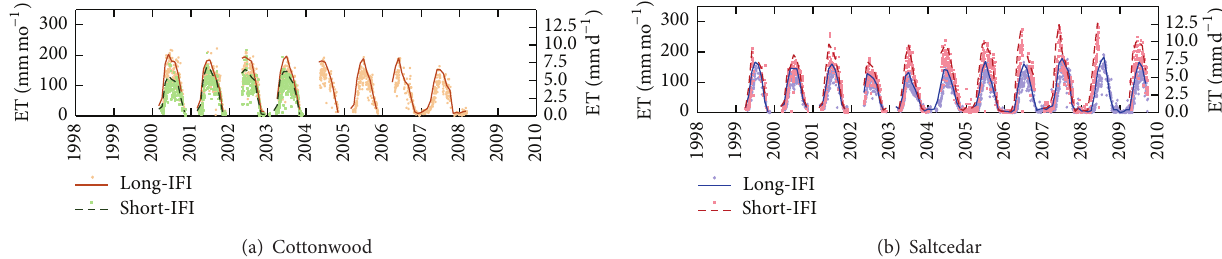
Figure 3: Total monthly (lines) and daily (symbols) ET at cottonwood (a) and saltcedar (b) sites. Long IFI is indicated by the solid line and small circles. Sites with a short IFI are indicated by the broken line and small squares. The first day of each year is indicated along the 𝑥 -axis.